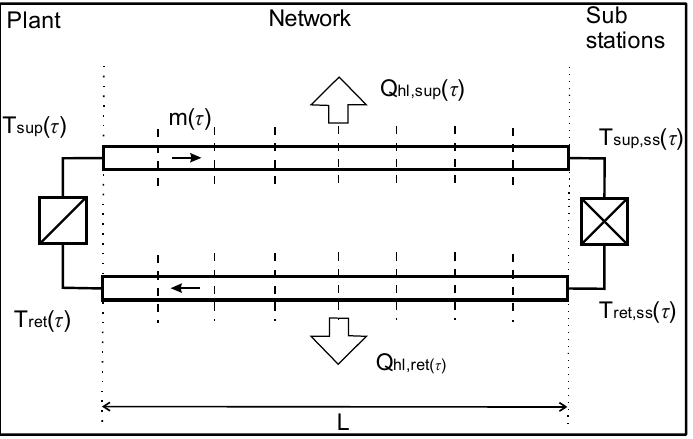
Figure 4. Simplified DHN model.